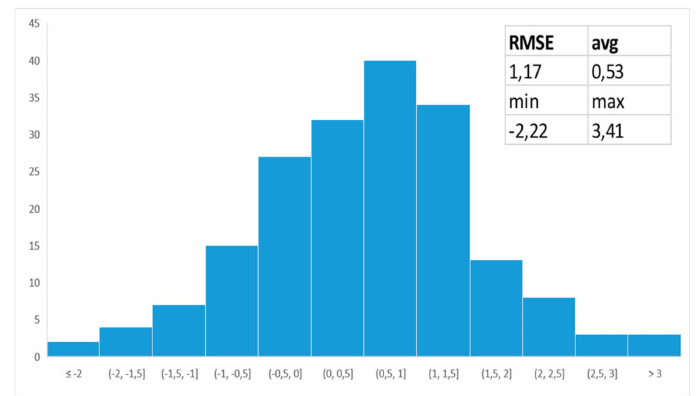
Figure 6. The probability distribution of error, the means correspond to biases (systematic effect) and the variances correspond to random effects; values are in meters. RMSE is at 1.17